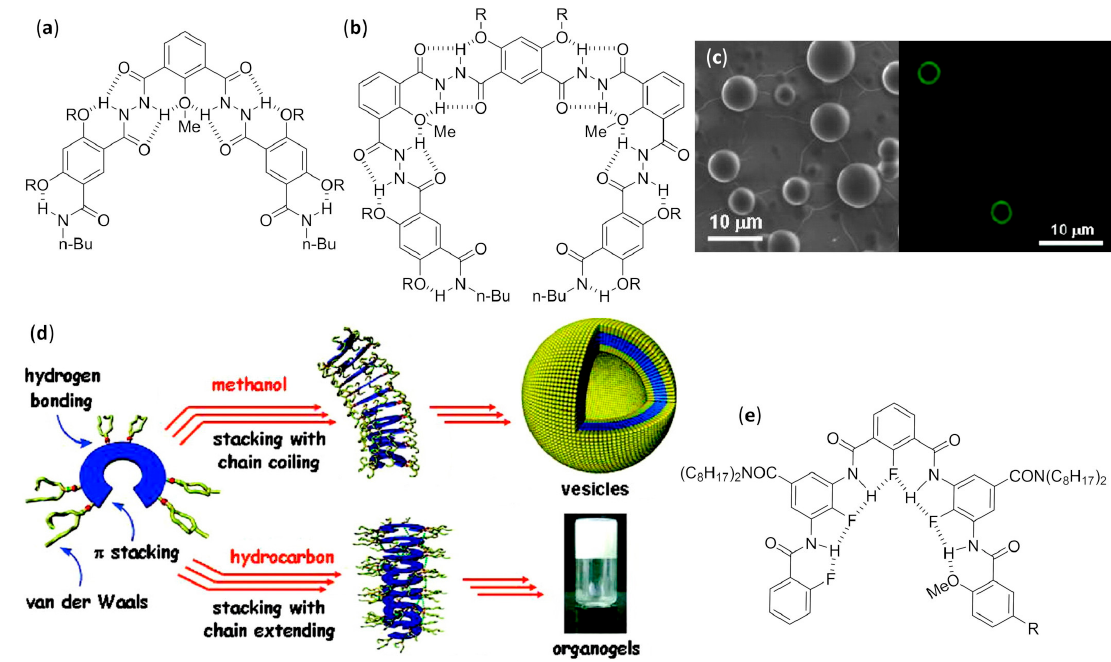
Figure 14. ( a , b ) General structures of aromatic hydrazide foldamers studied (Refs. [174,175]); ( c ) Representative SEM and fluorescence images of micelles formed by aromatic hydrazide foldamers in methanol (reprinted with permission from Ref. [174]); ( d ) Tentative model for the formation of vesicles (in methanol) and organogels (in hydrocarbon solvents) (adapted with permission from Ref. [174]); ( e ) Structure of a vesicles-forming arylamide foldamer with a continuous pattern of bifurcated intramolecular hydrogen bonds (Refs. [176,177]).